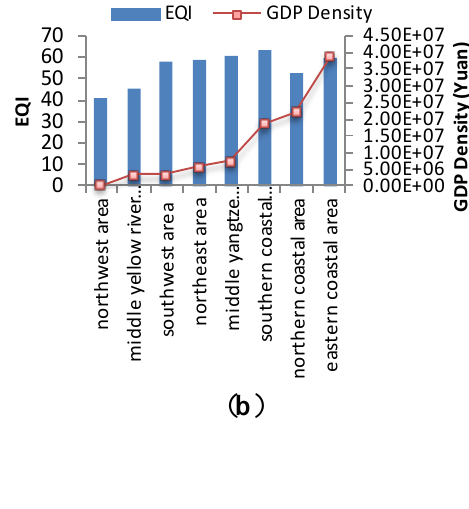
Figure 15. Relationship between EQI, population and GDP density in eight economic regions in 2010. ( a ) EQI and population; ( b ) EQI and